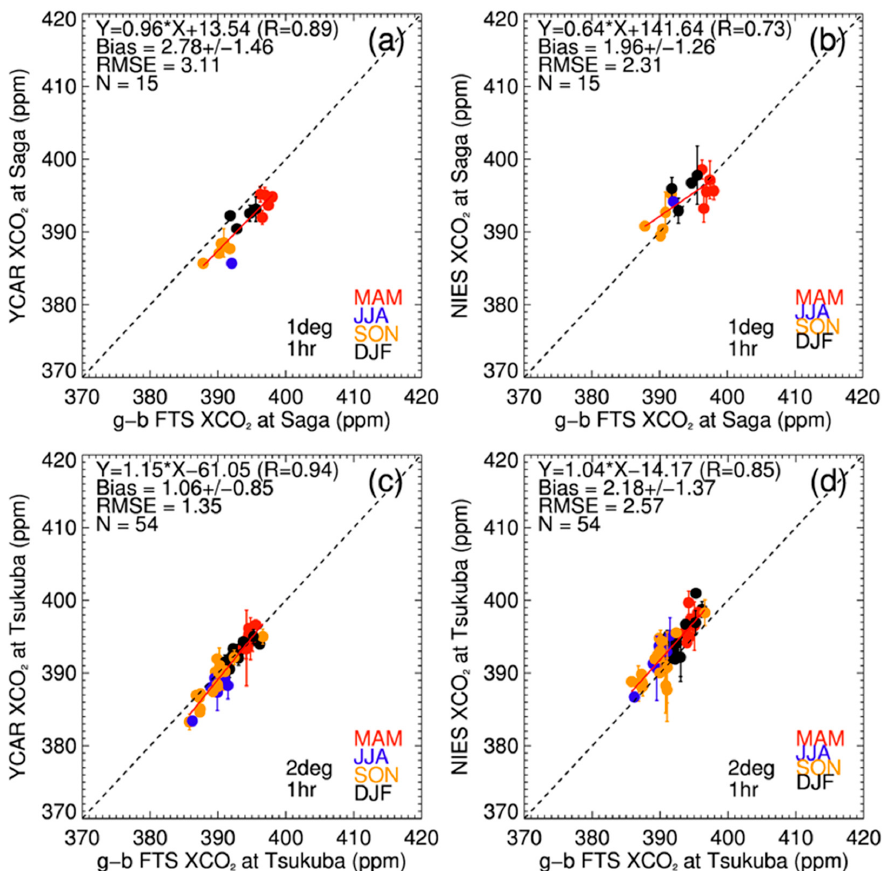
Figure 7. The comparison of XCO 2 retrieved from YCAR and the National Institute for Environment Studies (NIES) algorithm with ground-based FTS: ( a ) YCAR and ( b ) NIES retrievals at Saga station; ( c ) YCAR and ( d ) NIES retrievals at Tsukuba station.